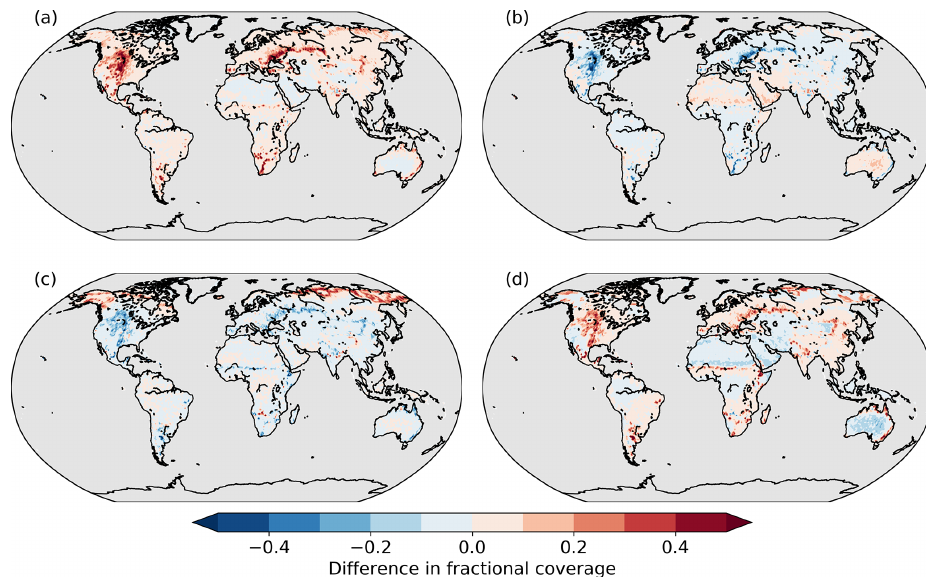
Figure 3. Difference in fractional coverage of (a) Noextremes trees, (b) Noextremes grasses, (c) Hotdry trees, and (d) Hotdry grasses compared to the Control scenario.